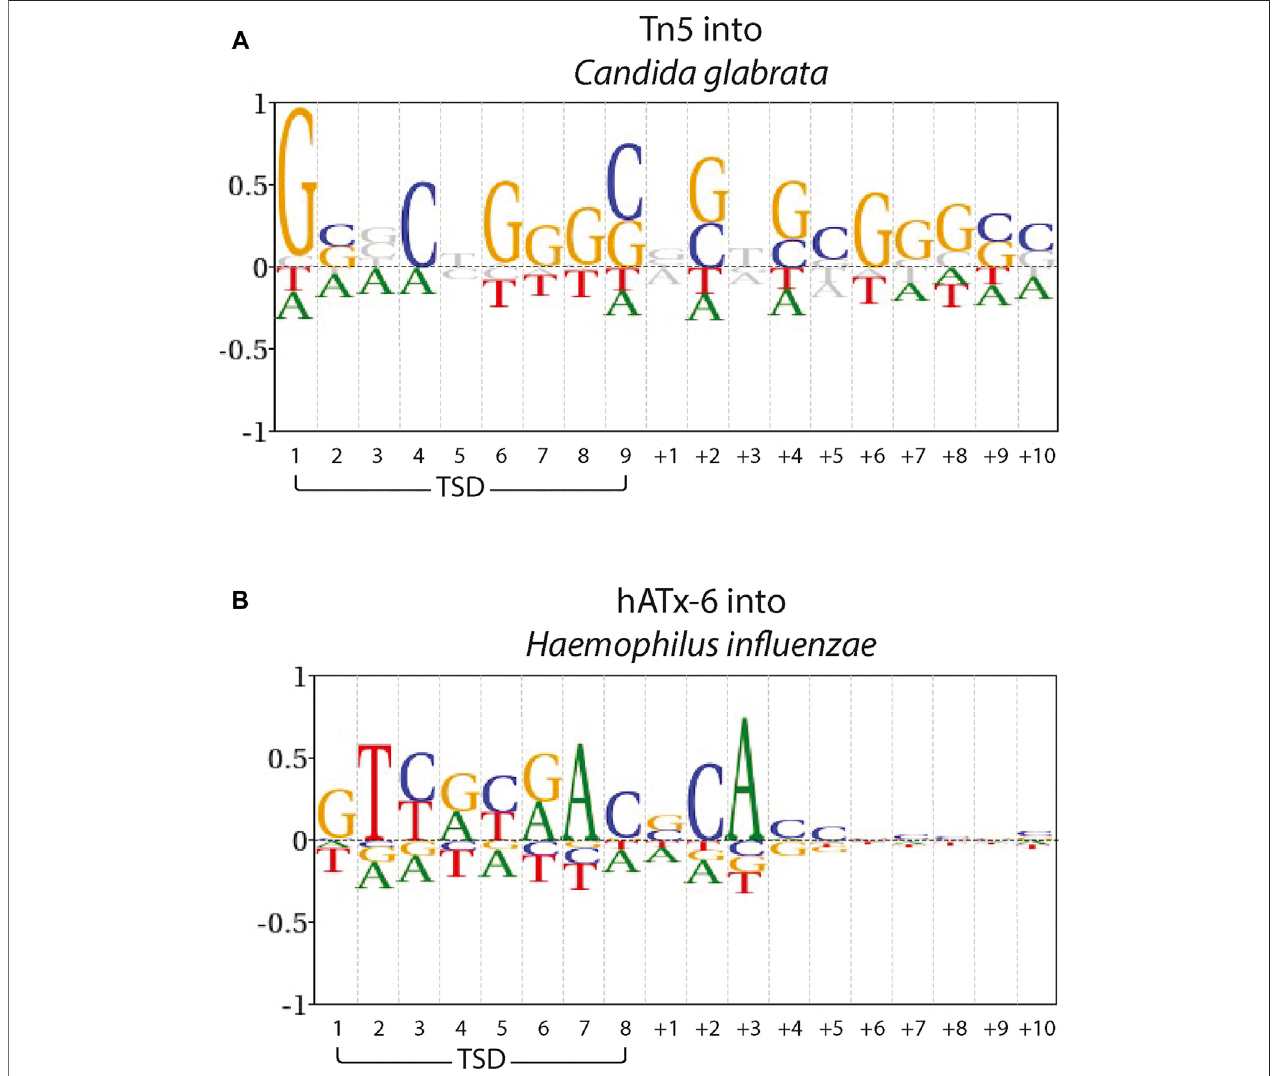
FIGURE 6 | Target site preferences of Tn5 and hAtx-6 transposases. Blogo sequence logos of (A) Tn5 into C. glabrata subtelomeric DNA and (B) hATx-6 into H. in fl uenzaeDNA.TheTargetSiteDuplication(TSD)andthe fl anking10basesas ‘ + x ’ areindicated.BasefrequenciesareshowncomparedwiththeoverallDNAcontentof (A) C. glabrata A: 0.32, C: 0.19, G: 0.18, T:0.31 and (B) H. in fl uenzae A: 0.31, C: 0.19, G: 0.19, T: